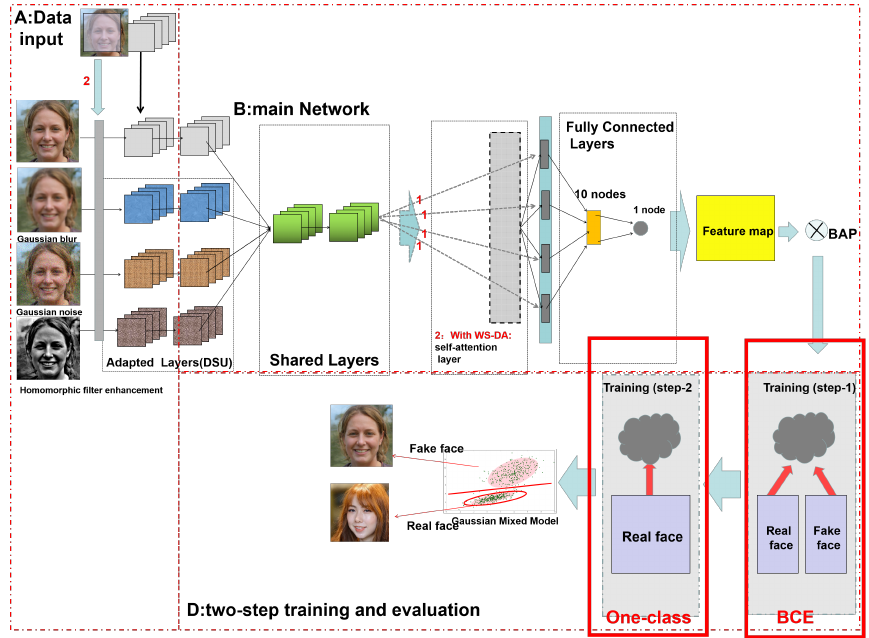
Figure 7. The process of training. In this figure, the fake face is from the open source StyleGAN dataset and the real face is from the open source FFHQ